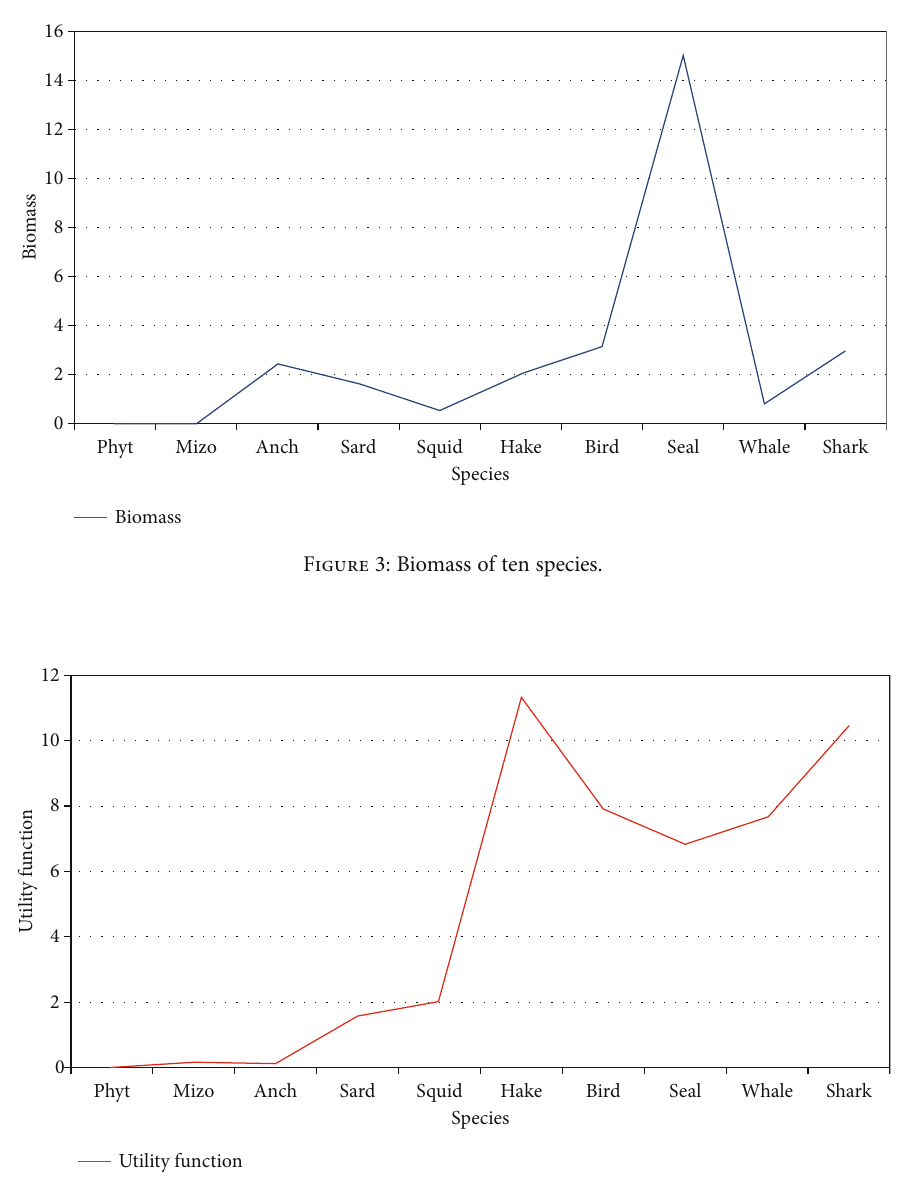
Figure 4: Utility function of ten